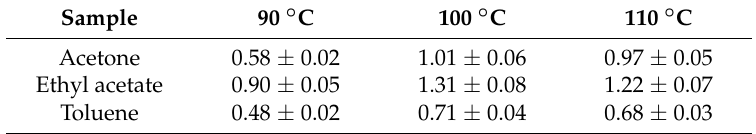
Table 3. Equilibrium adsorption capacities (mmol/g) of Dt/S-1 (5 wt%) prepared at different temperatures.